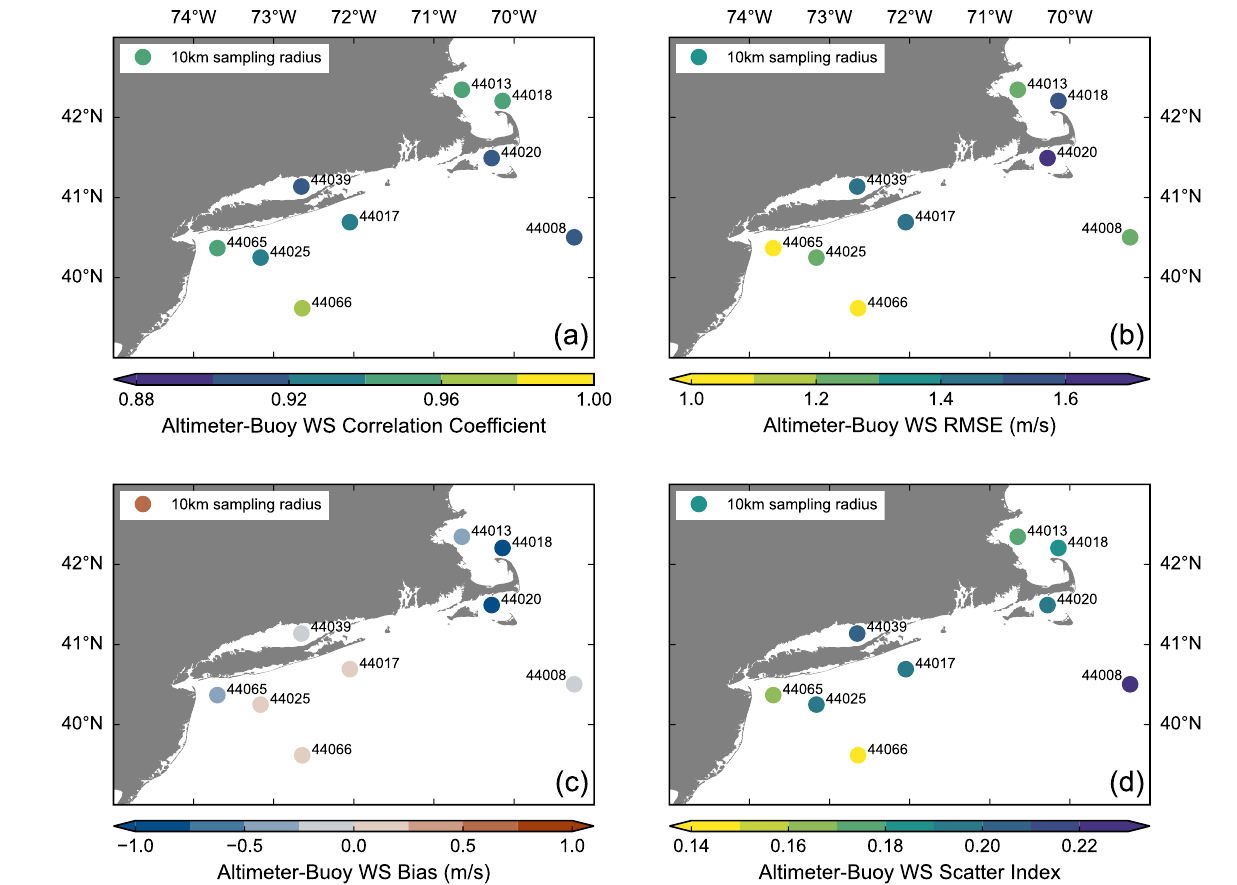
Figure 7. WS validation metrics of the collective altimeter dataset against the collocated buoy observations at each station. Pearson’s correlation coefficient ( a ), RMSE ( b ), Bias ( c ), and SI ( d ) maps visualize the comparison spatially in the